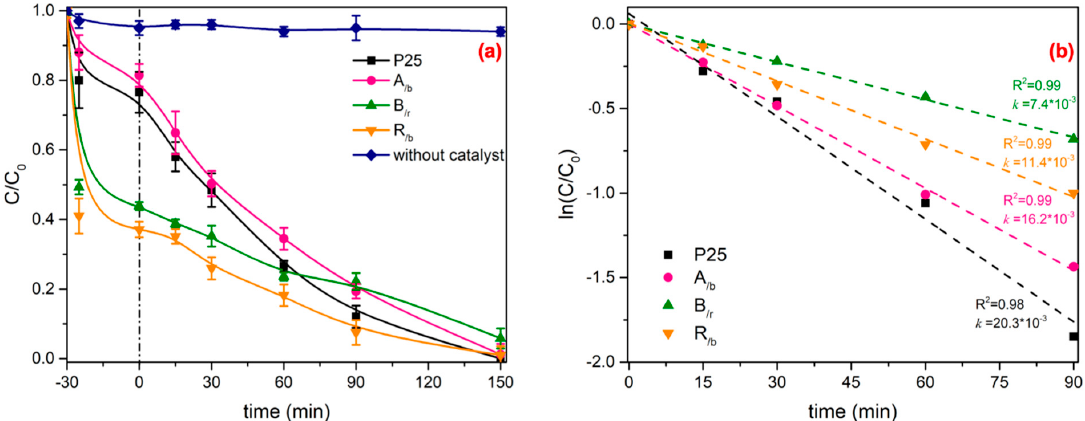
Figure 8. ( a ) Combined adsorption-photocatalytic elimination curves of methyl orange for three mixed-phase TiO 2 nanomaterials with the commercial P25 and with no catalyst loading and ( b ) First-order photocatalytic kinetic plots (adsorption period excluded). Conditions; catalyst loading 1 g TiO 2 /L, C MO : 25 mg/L.